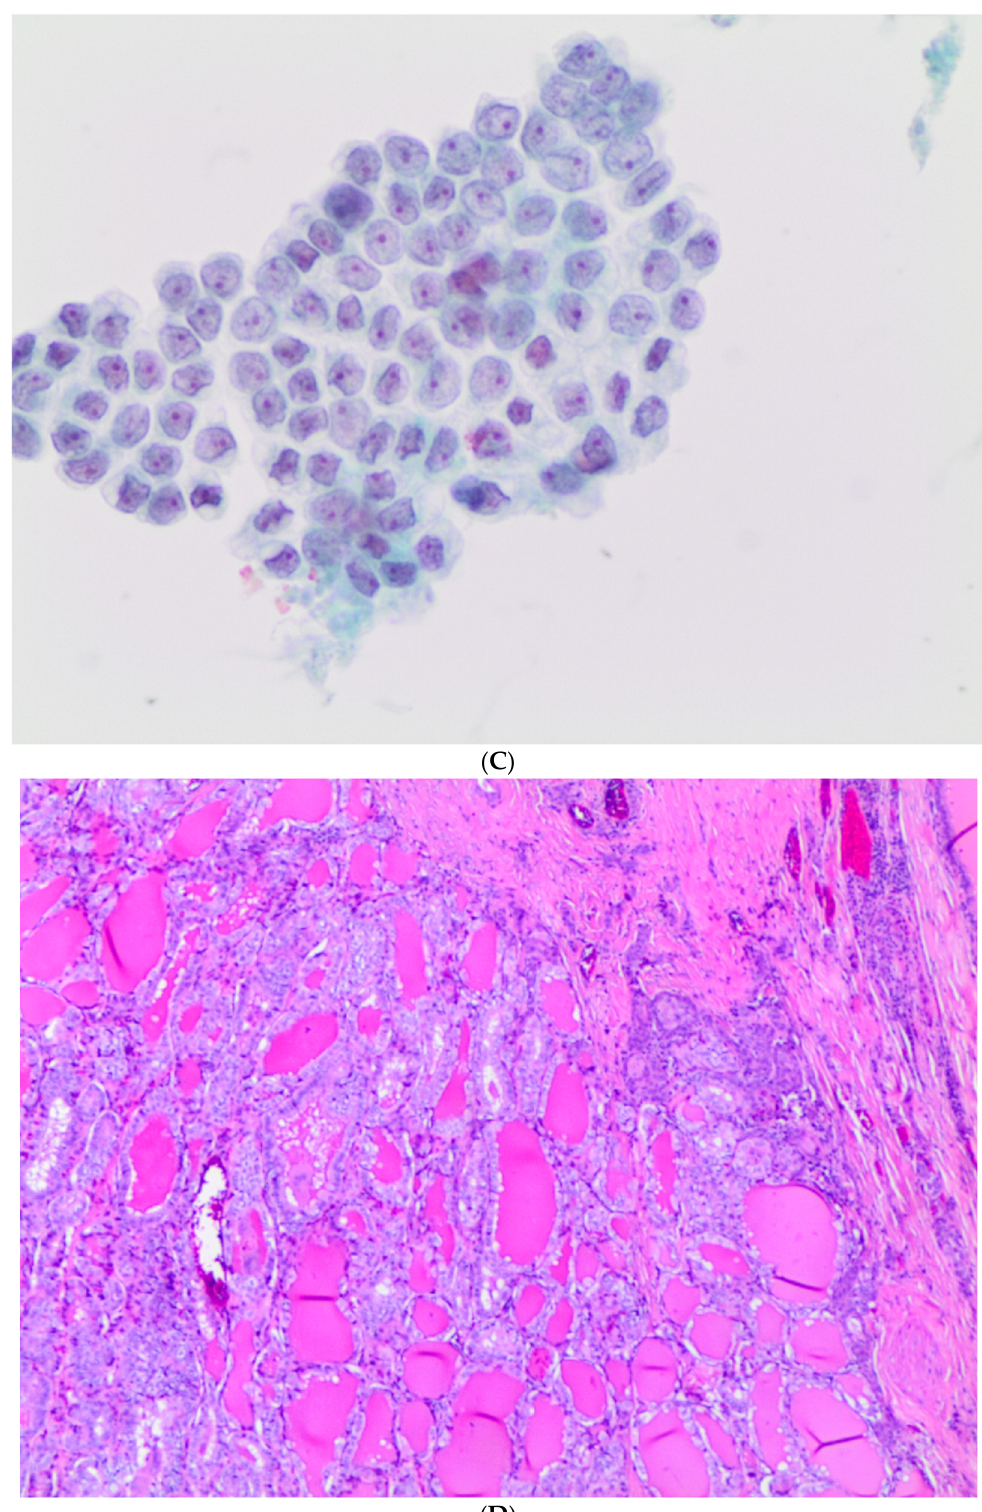
Figure 1. ( A ) Ultrasound picture from a subcentimeter lesion that underwent fine needle aspiration cytology. ( B , C ) The picture shows the morphological features diagnostic for a suspicious malignancy characterized by atypical nuclei with some grooves in absence of univocal features of carcinoma (200× and 400× liquid-based cytology (LBC), respectively). ( D ) The picture shows the histological features from the same case diagnosed as a follicular variant of papillary thyroid carcinoma (FVPTC) (200×, H&E).